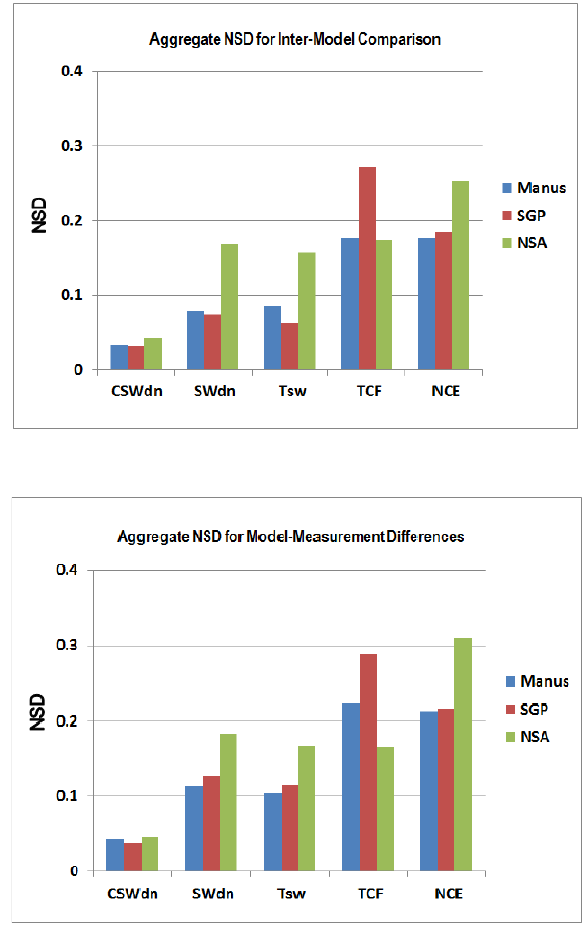
Fig. 5. The aggregate normalized standard deviation (NSD) of annual mean surface downward solar radiation under cloud-free skies (CSWdn) and all-skies (SWdn), cloud transmissivity (Tsw, SWdn/CSWdn), total cloud fraction (TCF), and cloud effect (NCE, CSWdn-SWdn normalized by TCF) over Manus, SGP and NSA, for inter-model comparison within 11 GCMs (top) and model- measurement difference (bottom),